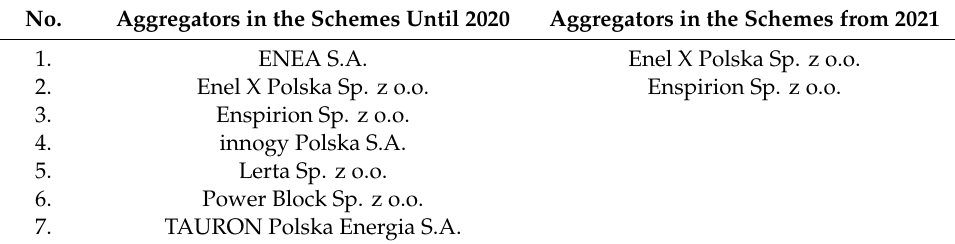
Table 1. Aggregators in the DSR schemes in place up to and including 2020 [38]. No. Aggregators in the Schemes Until 2020 Aggregators in the Schemes from